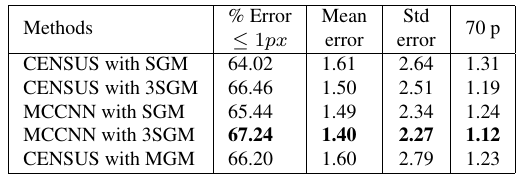
Table 1. Disparity errors (in pixels) on Montpellier (France). All pixels are considered (no rejection criteria). Optimization with 3SGM uses OSM